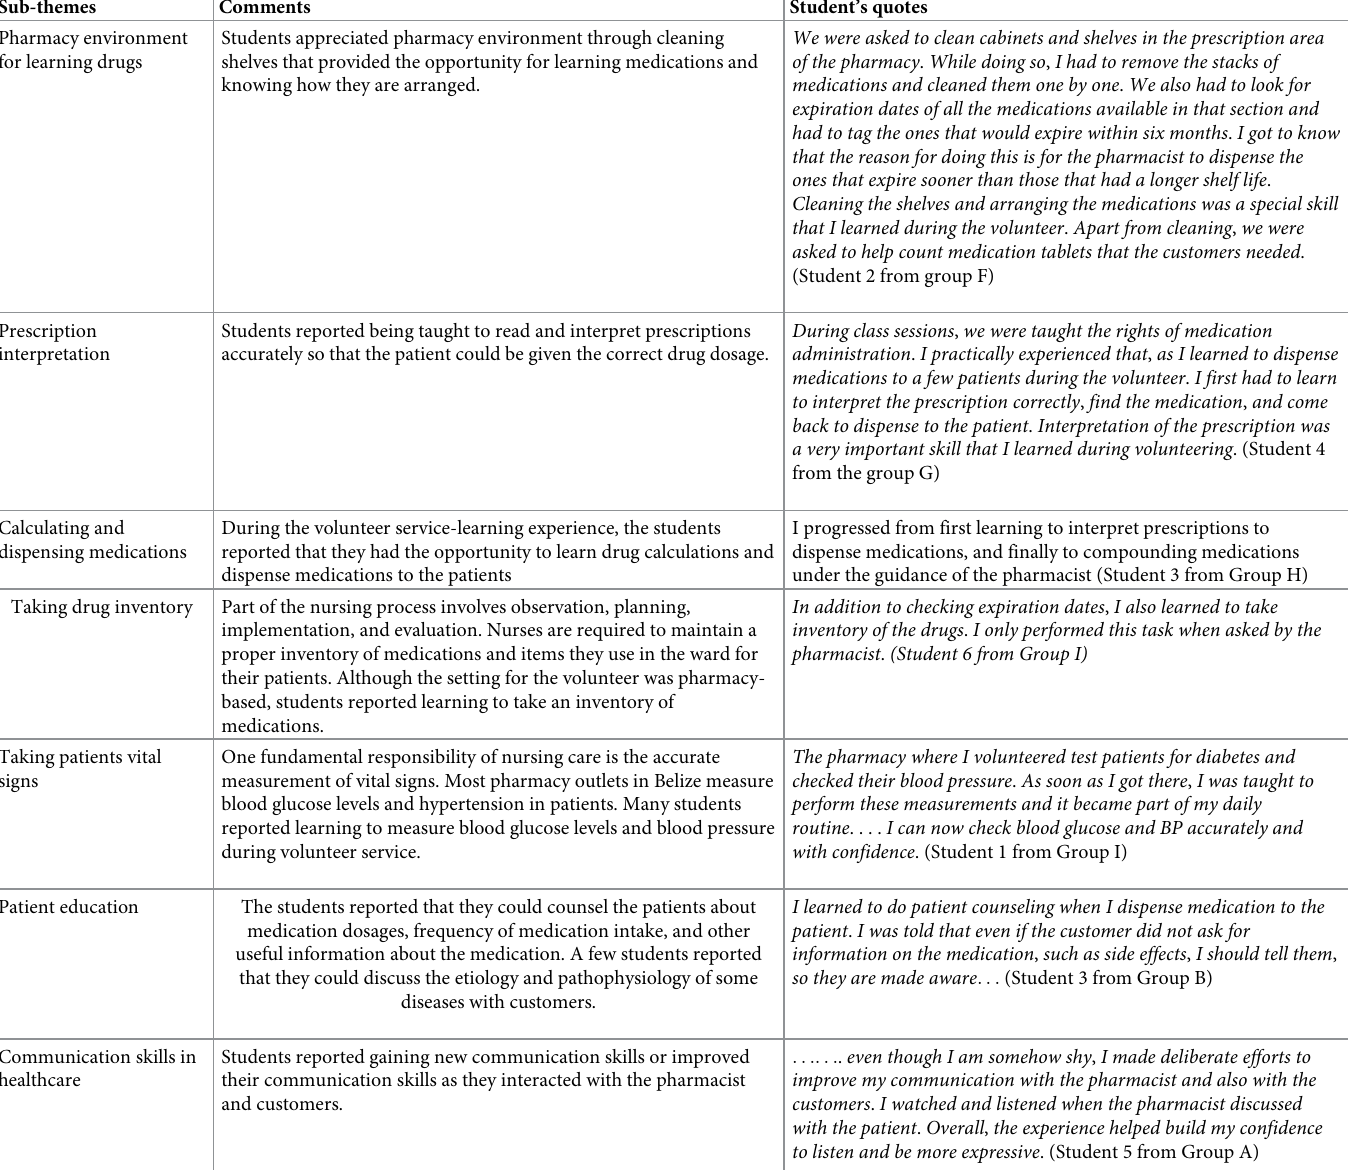
Table 2. Student’s acquisition of skills from pharmacy service-learning at community/hospital pharmacies in